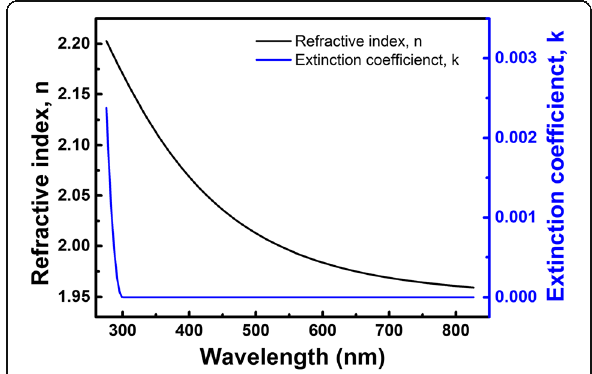
Fig. 4 Optical constants (refractive index and extinction coefficient) of the 87-nm AlN thin